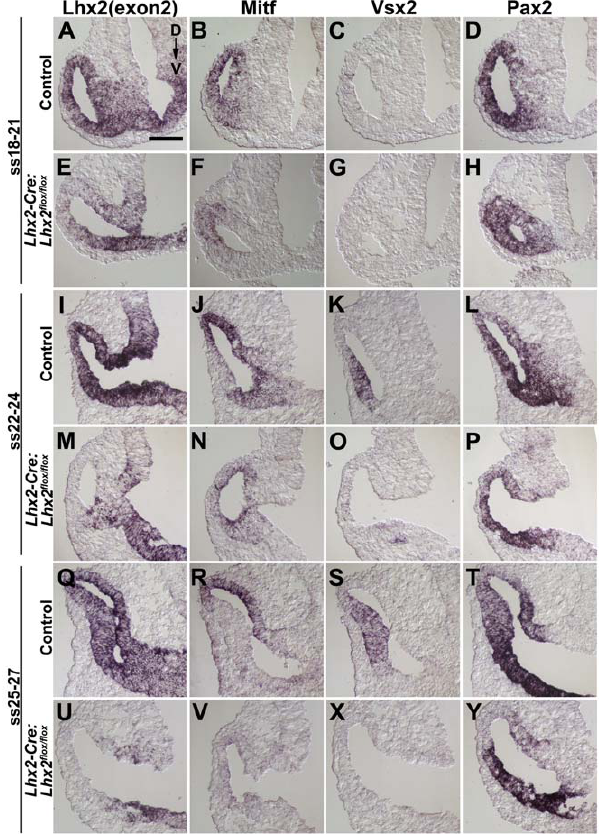
following conditional inactivation of Lhx2 in the eye-commit- ted progenitor cells. (A–Y) In situ hybridisation analyses of coronal sections of the optic vesicles in control and mutant ( Lhx2-Cre: Lhx2 flox/flox ) embryos at the indicated developmental stages. A,E,I,M,Q,U are in situ hybridisation analyses to detect exon 2 (exon2) in the Lhx2 mRNA to reveal the domain in the optic vesicle where the Lhx2 gene has been inactivated. B,F,J,N,R,V are in situ hybridisation analyses to detect expression of the RPE cell-specific gene Mitf , which is expressed in the entire optic vesicle in early development and eventually becomes RPE cell-specific. C,G,K,O,S,X are in situ hybridisation analyses to detect expression of neural retina specific gene Vsx2 . D,H,L,P,T,Y are in situ hybridisation analyses to detect expression of the optic stalk-specific gene Pax2 . Dorsal to Ventral orientation for all sections is indicated in A. Scale bar: 100 m m.